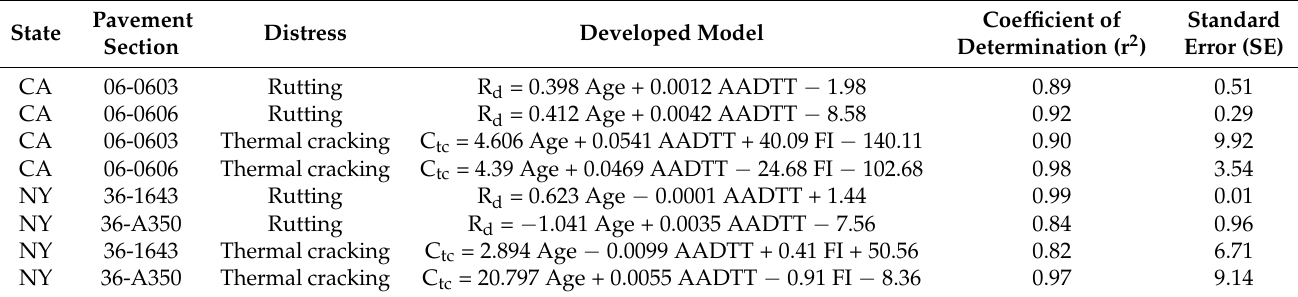
Table 2. Deterioration models of the selected LTPP test